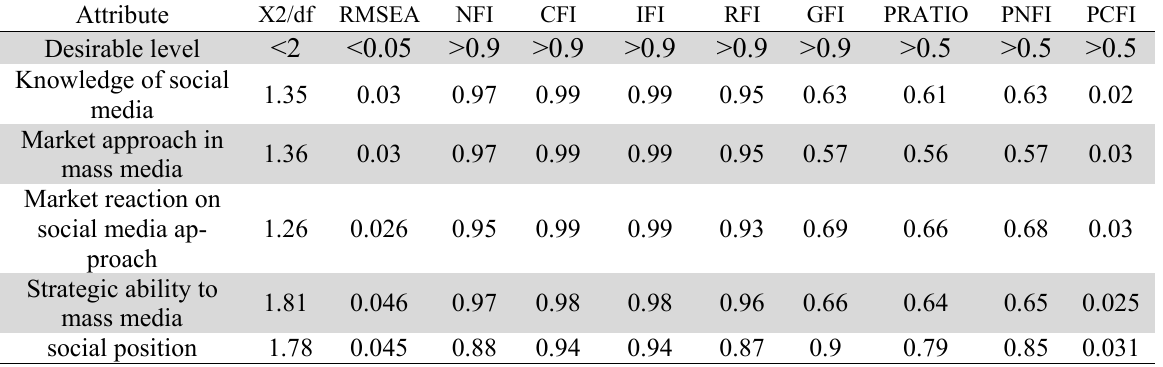
The summary of the statistical